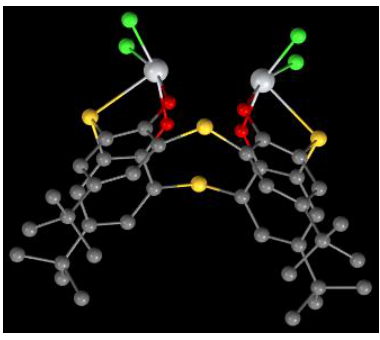
Figure 10. Molecular structure of 36 [21].